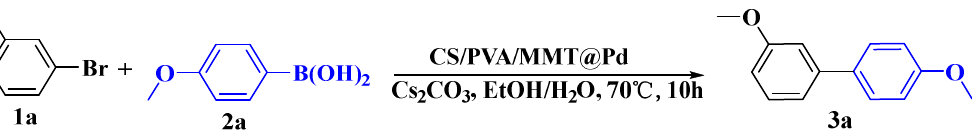
Figure 10. Suzuki coupling reaction of 4-methylbromobenzene with 4-tert-butylbenzeneboronic acid.